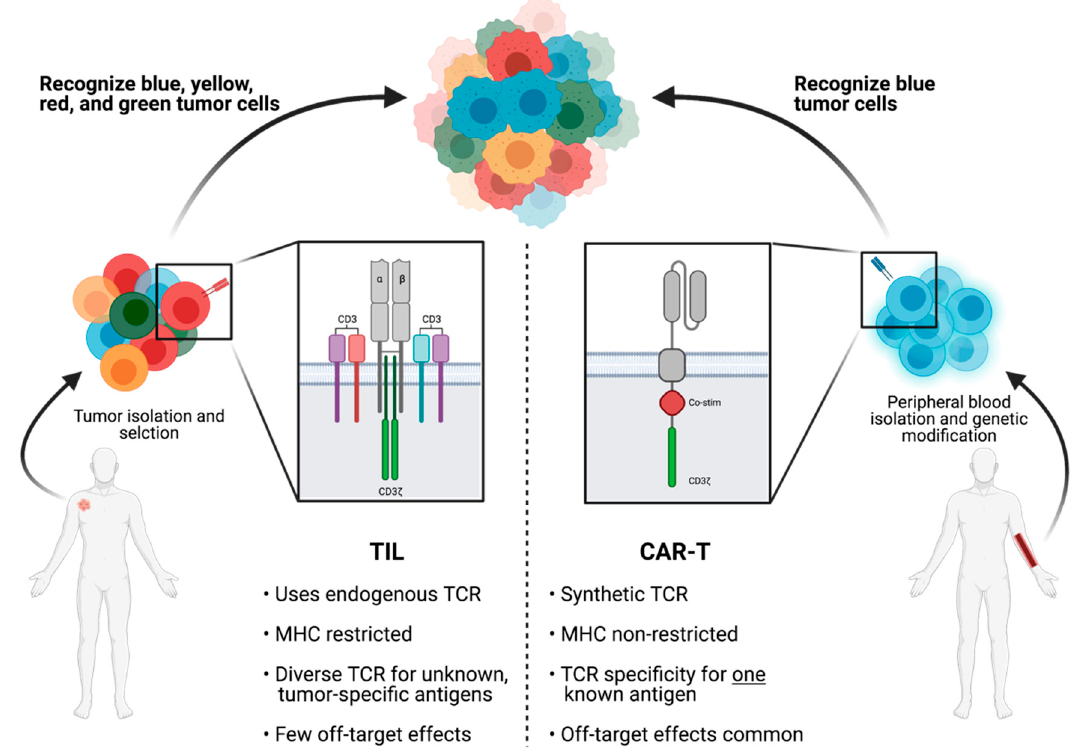
Figure 3. Structural and functional differences between TILs and CAR-Ts in antitumor treatment. ACT can be accomplished using either TILs or CAR-Ts. TILs use endogenous T cell receptors (TCRs) that are MHC restricted. The inherent diversity of TCRs present on TILs allows recognition of a wide range of tumor neoantigens expressed by heterogeneous tumor cells. In contrast, CAR-Ts have synthetic receptors modeled after non-MHC restricted monoclonal antibodies. These receptors contain co-stimulatory and signaling molecules that can independently activate the T cell without recruitment of additional factors. However, as CARs are synthesized to have high affinity binding against one known neoantigen, they are more prone to have off-target effects if the neoantigen is present on normal tissues. TIL (tumor-infiltrating lymphocytes); CAR (chimeric antigen receptor); TCR (T cell receptor); MHC (major histocompatibility complex).